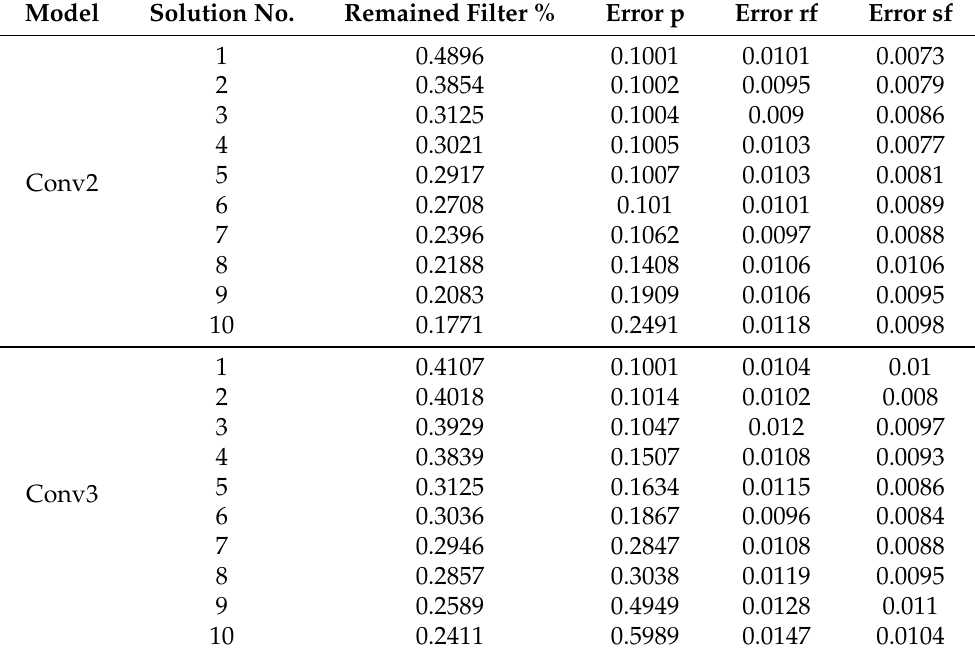
Table 9. Pruning results with different fine-tuning strategies on Conv2 and Conv3. Error p means the error of pruned model which is not fine-tuned, and Error sf and Error rf mean the error of the fine-tuned model with random initialized weight and shared original weight, respectively.